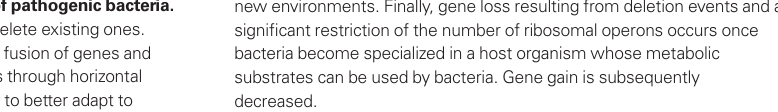
Figure 6 | genetic events leading to speciation of pathogenic bacteria. Polymerase errors can introduce new genes and/or delete existing ones. Recombination events cause duplication, deletion, or fusion of genes and yield new gene architecture. Bacteria may gain genes through horizontal gene transfers, thereby gaining fitness and the ability to better adapt to